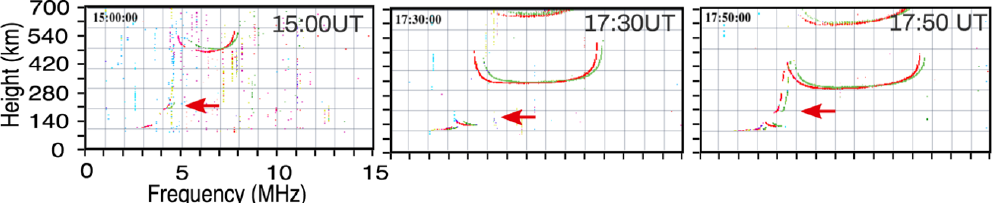
Figure 4. Ionograms collected at CG at 15:00, 17:30, and 17:50UT, showing the F1 layer disappearance during the eclipse hours on 14